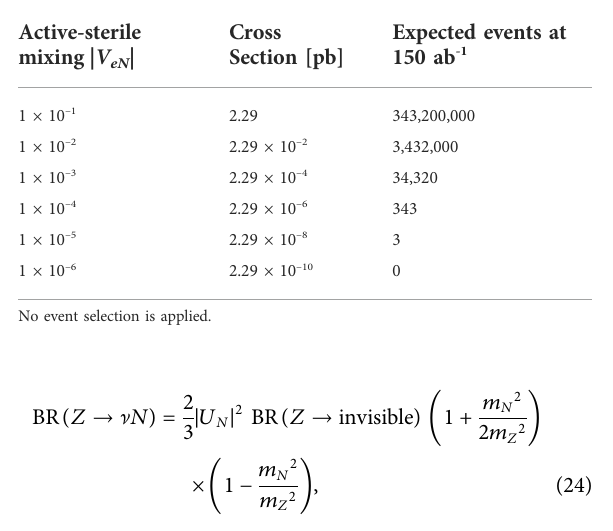
FIGURE 10 RepresentationofaneventdisplayatanFCC-eedetectorofa HNL decay into an electron and a virtual W decaying hadronically. Courtesy of the FCC collaboration.